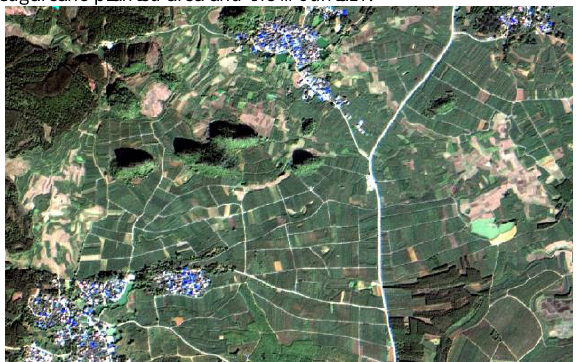
Figure 4. ZY-3 Orthorectified fused multispectral image